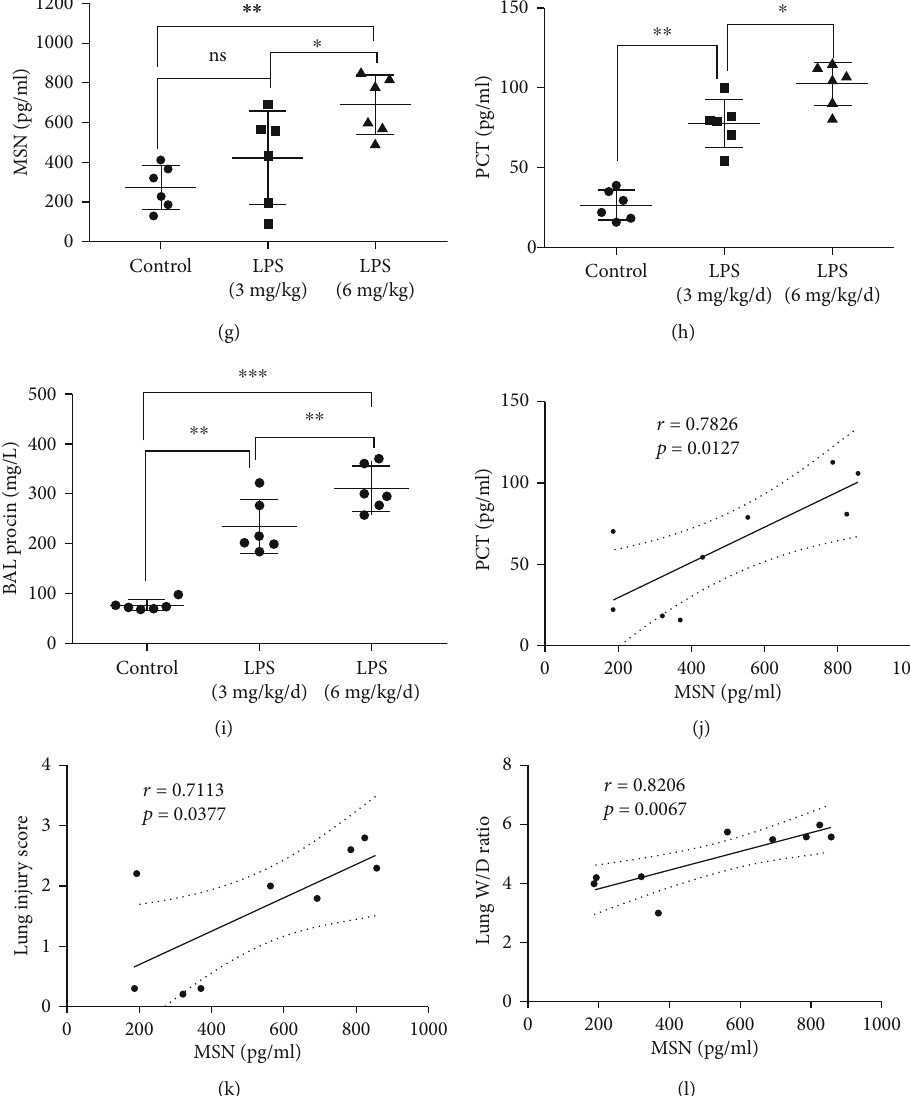
Figure 2: LPS increased the MSN expression and lung injury in mice. BALB/c mice were intraperitoneally injected with the indicated doses of LPS for two days, and their serum MSN and PCT levels were examined by ELISA. Their lung W/D ratios and BALF protein levels were measured. (a) H&E staining of lung tissue sections in di ff erent groups of mice (magni fi cation × 100). (b) Lung injury scores. (c) Pulmonary edema in di ff erent groups of mice. (d) The lung W/D ratios in di ff erent groups of mice. (e) LPS increased p-MSN and MSN expression in lung tissues in di ff erent groups of mice, and the semiquanti fi cation for WB was shown in (f). Serum MSN (g) and PCT (h) levels in di ff erent groups of mice. (i) BALF protein concentrations in di ff erent groups of mice. The correlation between serum MSN and PCT (j), serum MSN and lung injury scores (k), serum MSN levels, and lung W/D ratios (l). NS: not signi fi cant; ∗ p < 0 : 05 , ∗∗ p < 0 : 01 , ∗∗∗ p < 0 : 001